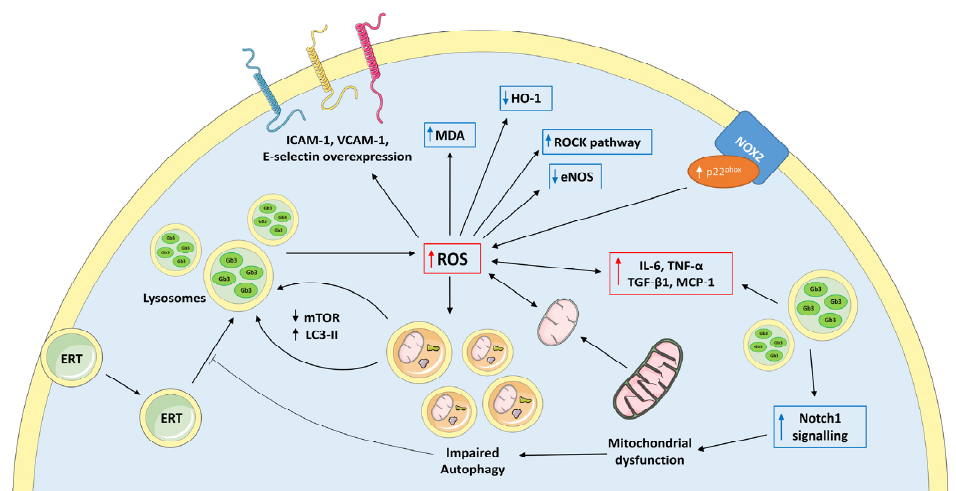
Figure 2. Overview of the main intertwined secondary intracellular mechanism involved in Fabry pathophysiology. The oxidative imbalance and the pro-inflammatory state triggered by Gb3 accumulation, along with overactivation of NOX2 and mitochondria dysfunction, led to impaired autophagy and altered intracellular trafficking, possibly providing a mechanistic explanation of the inability of ERT to halt disease progression. ERT, enzyme replacement therapy; ICAM-1, intercellular adhesion molecule-1; VCAM-1, vascular cell adhesion molecule-1; mTOR, mammalian target of rapamycin; LC3-II, microtubule-associated protein light-chain 3; MDA, malondialdehyde; HO-1, heme oxygenase 1; ROCK, rho kinase; eNOS, endothelial nitric oxide synthase; ROS, reactive oxygen species; NOX2, NADPH oxidase 2; IL-6, interleukin-6; TNF- α , tumor necrosis factor alpha; TGF- β 1, transforming growth factor β 1; MCP-1, monocyte chemoattractant protein-1. The figure was partly generated using Servier Medical Art, provided by Servier, licensed under a Creative Com- mons Attribution 3.0 Unported License.